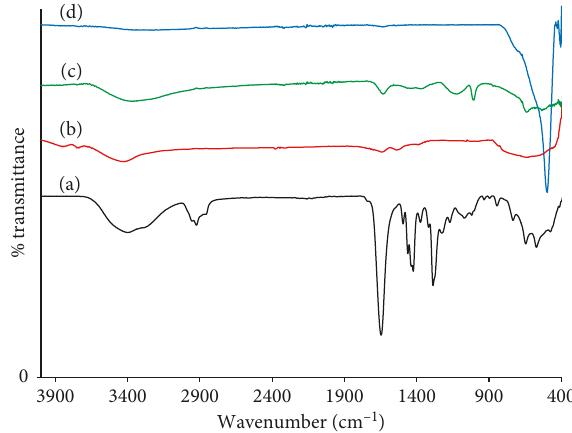
Figure 1: FTIR spectra of (a) PVP, (b) TiO TiO 2 hybrid nanoparticles.